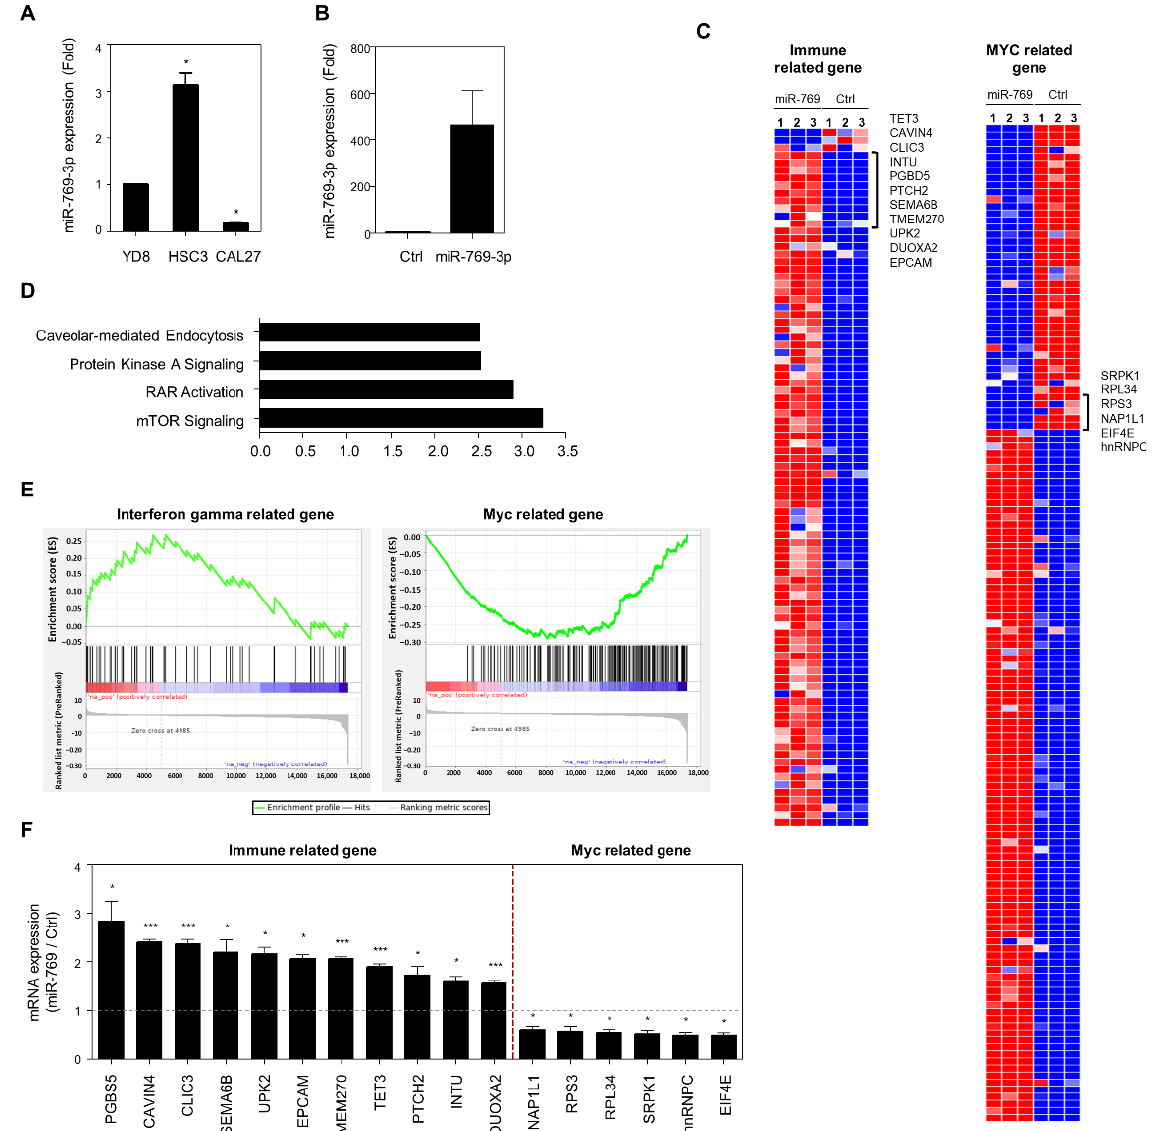
Figure 2. miR-769-3p overexpression promoted a stroma-related gene expression signature in oral squamous cell carcinoma (OSCC) cell lines. ( A ) Endogenous miR-769-3p expression in YD8, HSC3, and CAL27 cells; relative values to those of YD8 cells (set at 1.0) are presented; ( B ) CAL27 cells were transiently transfected with miR-769-3p or Ctrl miRNA for 48 h. miR-769-3p expression was assessed using RT-qPCR; ( C ) heatmap showing RNA-sequencing results for Ctrl miRNA- or miR-769- 3p-transfected cells. Red: increased expression; blue: decreased expression; ( D ) the IPA analyses of RNA-sequencing data found canonical pathways significantly affected by miR-769-3p transfection; ( E ) gene set enrichment analysis of differentially expressed genes in Ctrl miRNA- and miR-769-3p- transfected cells. “Interferon-gamma-related” gene sets were significantly enriched, whereas the “MYC related” gene set was depleted in miR-769-3p-transfected cells; ( F ) immune-related and MYC related gene sets were validated using qRT-PCR. Relative values to those of Ctrl miRNA (set at 1.0) are presented. Data represent mean ± SD. p value was determined using two-tailed Student’s t-test. * p ≤ 0.05, *** p ≤ 0.001.